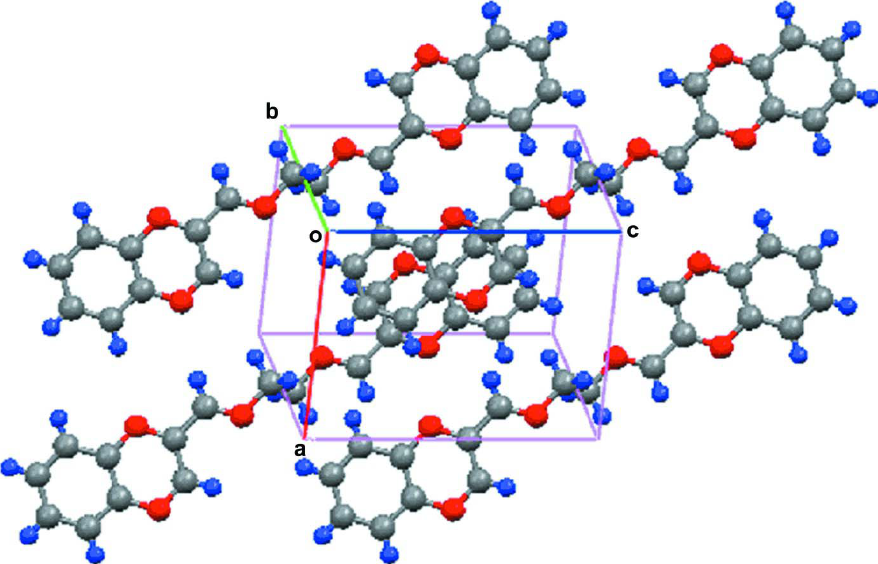
Figure 2 Unit cell packing diagram of N , N ′-bis[( E